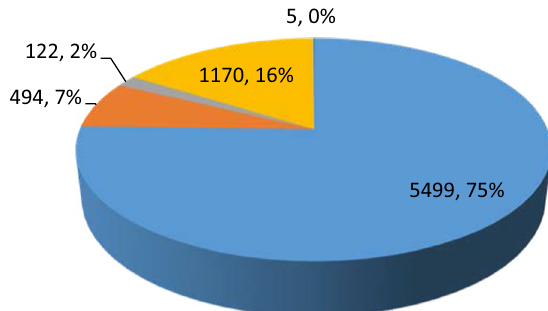
Fig. 3 Number of water users in